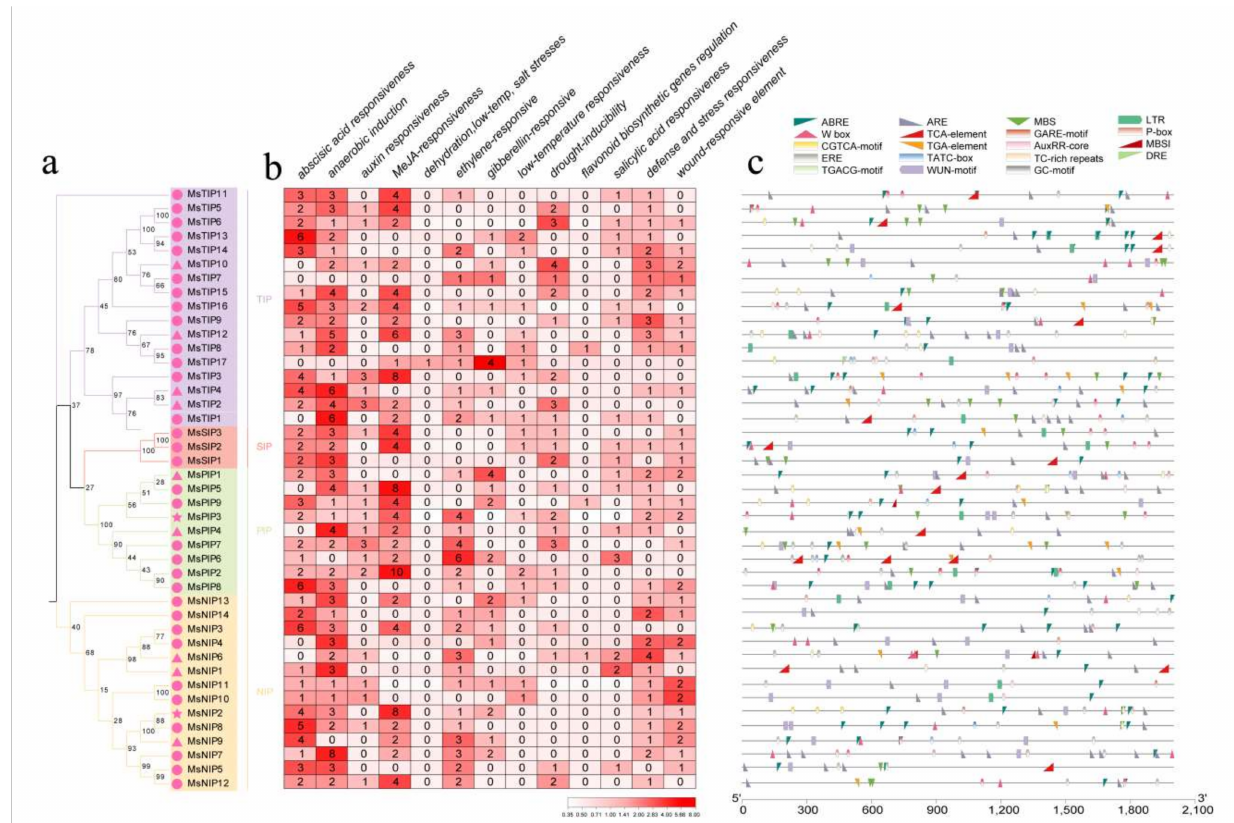
Figure 4. Analyses of cis -acting elements in the upstream promoter region of AQPs in M. sativa . ( a ) The phylogenetic analysis of the deduced AQP proteins of M. sativa; ( b ) The colors and numbers on the grid indicated the numbers of different cis -acting elements in these MsAQP genes, which is presented in the form of heatmap; ( c ) Colored blocks represented different types of cis -acting elements and their relative location in the promoter region of each MsAQP